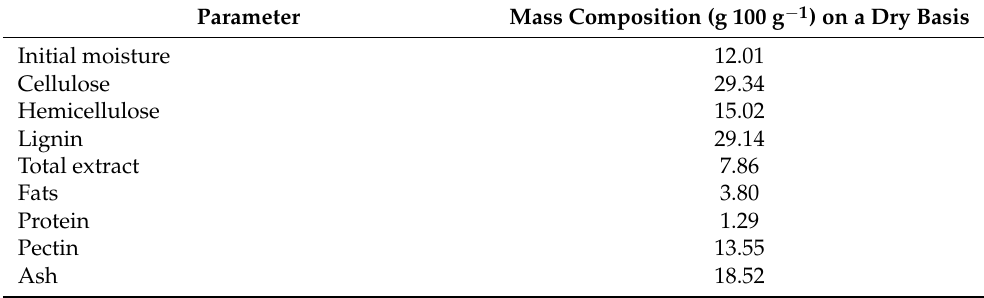
Table 9. Physicochemical characterization of rice